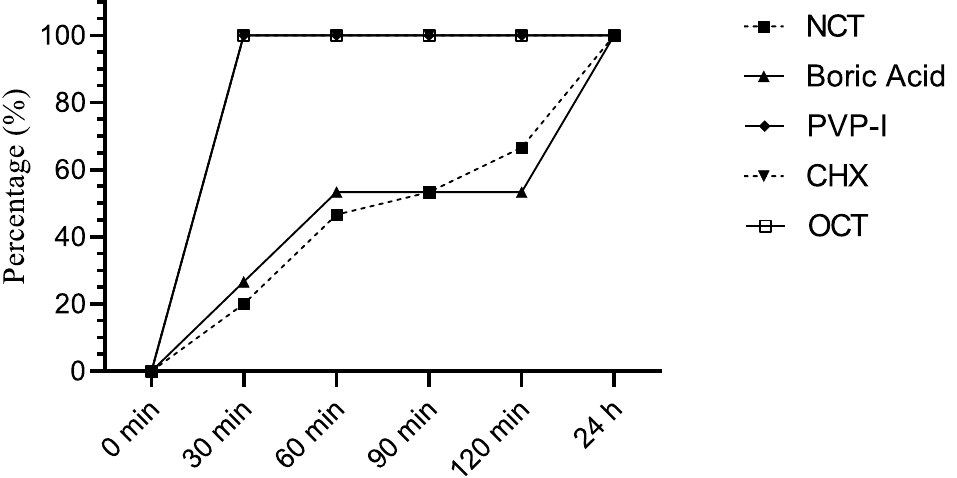
Figure 2. Percentage of C. non-albicans strains (n = 15) reduced by ≥4 log10 by antiseptics after indicated incubation periods.